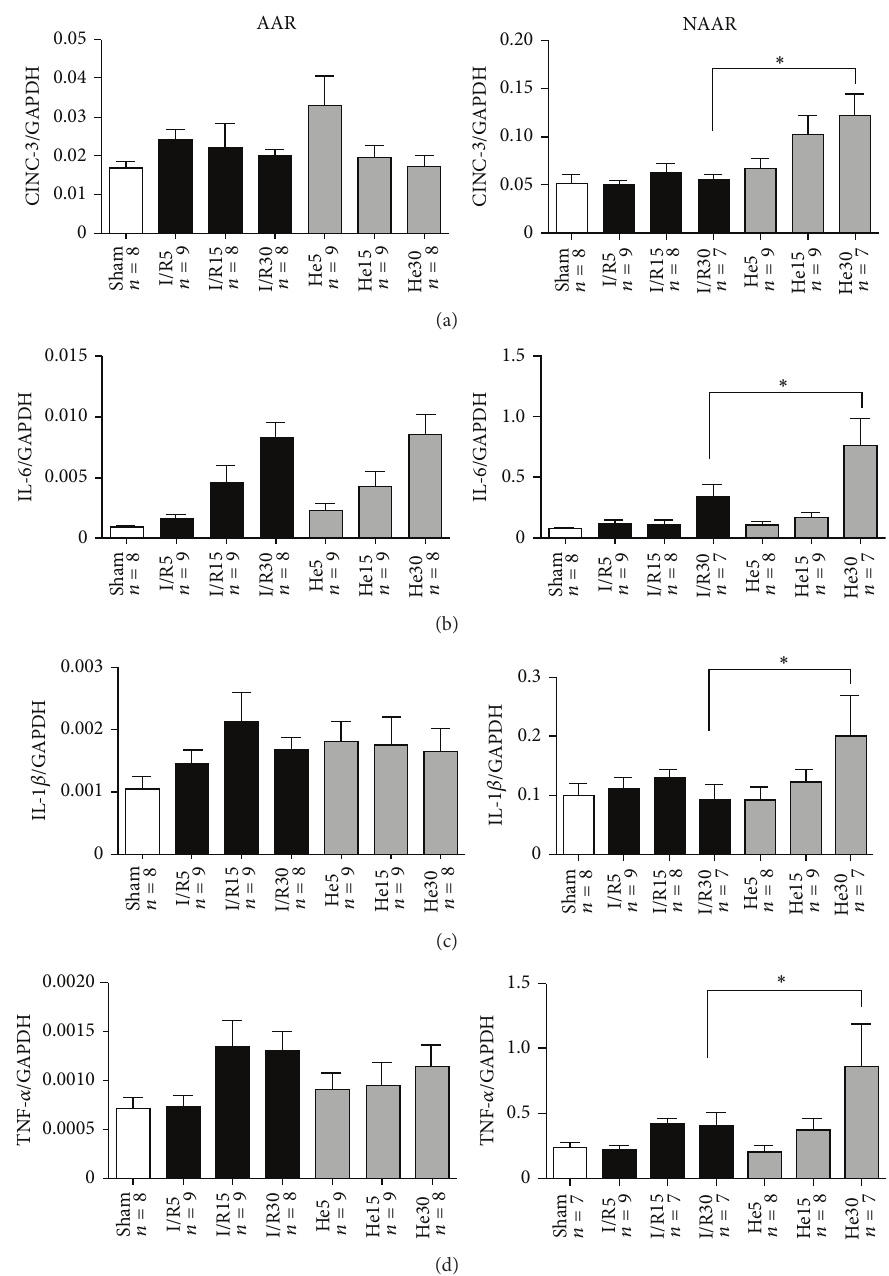
Figure 3: CINC-3 (a), IL-6 (b), IL-1 𝛽 (c), and TNF- 𝛼 (d) mRNA expression. Messenger RNA was analyzed in myocardial samples taken at the end of the experimental protocol. All animals underwent 15 min of stabilization and 25 min of ischemia (except for Sham) and 5, 15, or 30 min of reperfusion with or without helium. All data are shown as mean ± S.E.M. Amount of experiments in each group is shown below individual bars. To compare control (I/R) with helium intervention (I/R + He) at the various time points of reperfusion (5, 15, and 30 minutes), a two-way repeated measures ANOVA with Bonferroni correction for multiple testing was done. ∗ 𝑃 < 0.05 I/R in comparison to He.